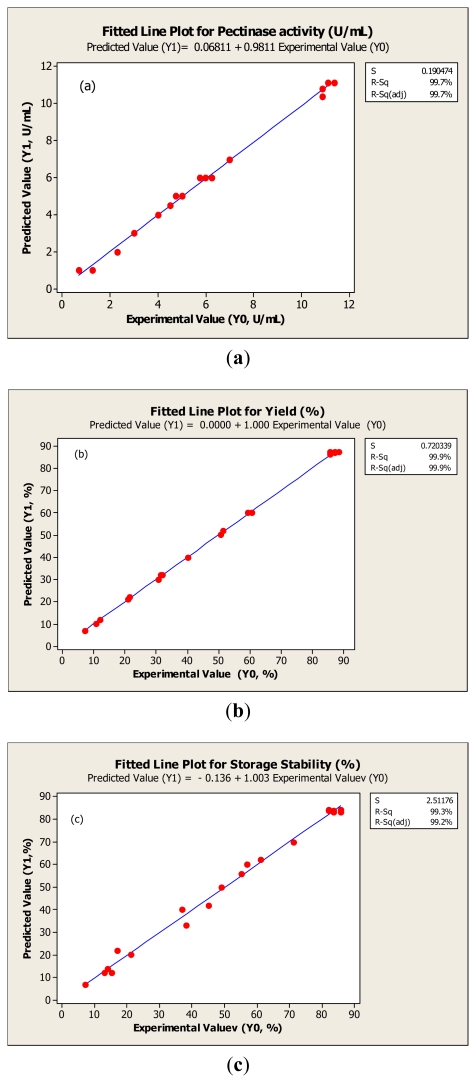
Fitted line plot indicating the closeness between predicted values (Y1) and experimental value (Y0) for pectinase activity (a), yield (b) and storage stability (c).